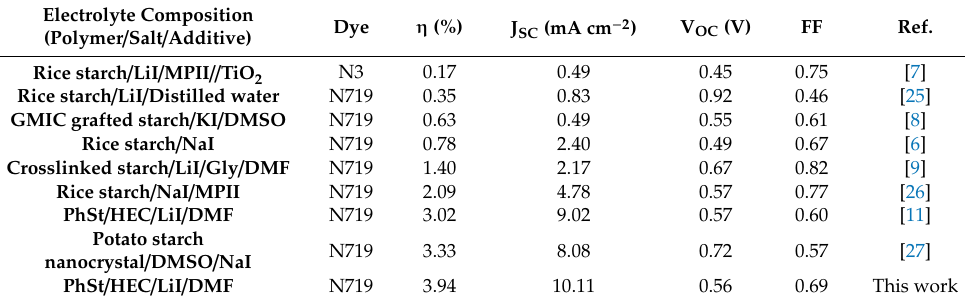
Table 3 abbreviation list: LiI: lithium iodide, MPII: 1-methyl-3-propylimidazolium iodide, TiO 2 : titanium dioxide, GMIC:1-glycidyl-3-methylimidazoliumchloride, KI:potassiumiodide, DMSO:N,N-dimethylsulfoxide, NaI:sodium iodide, Gly: glycerol and DMF:N,N-dimethylformamide.